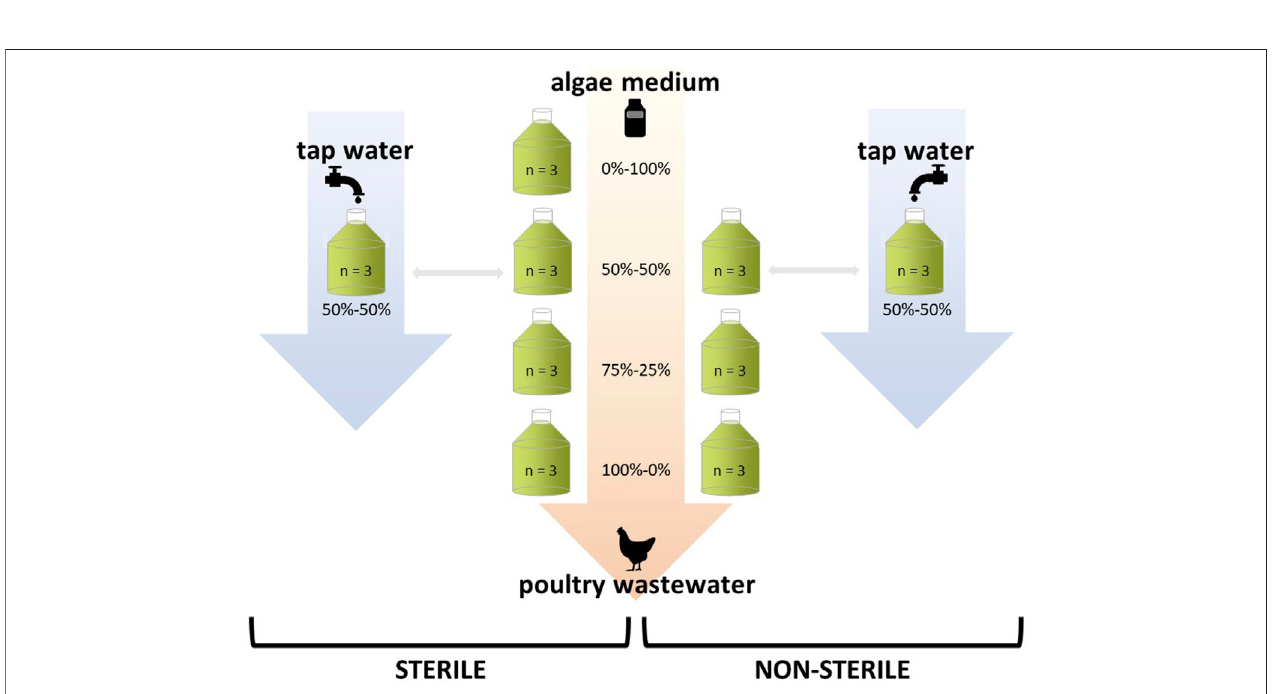
FIGURE 2 | Experimental setup to assess C. sorokiniana growth on non-/sterilized wastewater dilutions. Algae were cultured on 100, 75, 50 and 0% (control) wastewater. Dilutions weremade withfreshwatermedium,or withtap water(for the50%wastewatertreatment). All wastewaterconditionswere either sterilized ornon- sterilized. Each experimental condition was replicated three